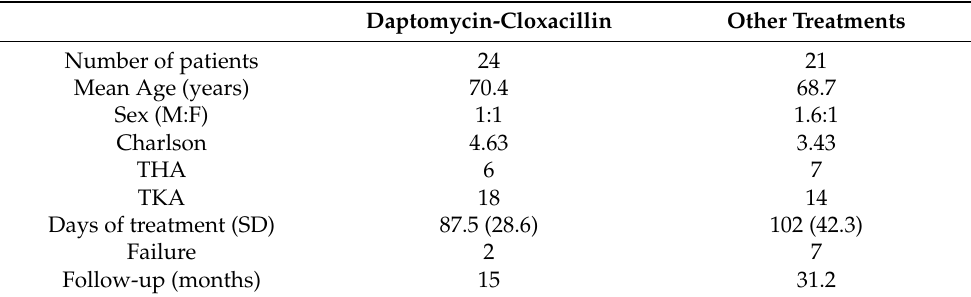
Figure 1. Days of treatment. Table 1. Demographic data according to treatment group.